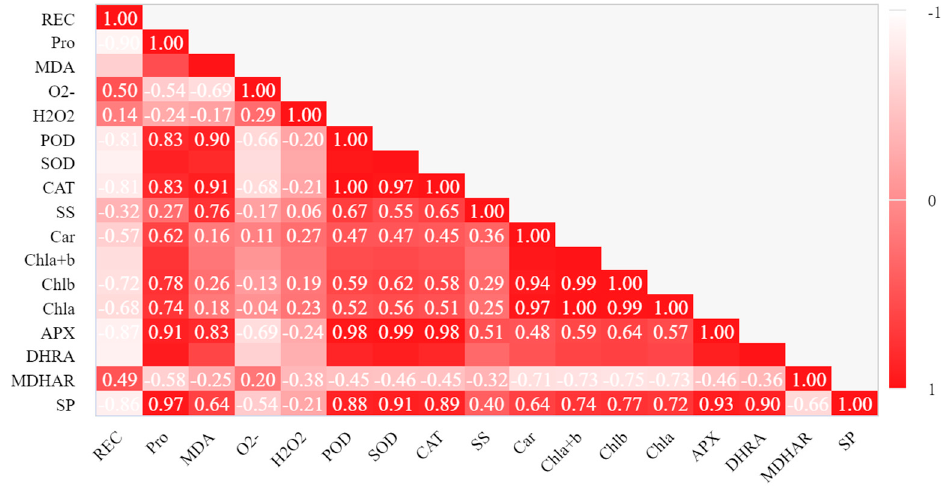
Figure 7. Pearson correlation